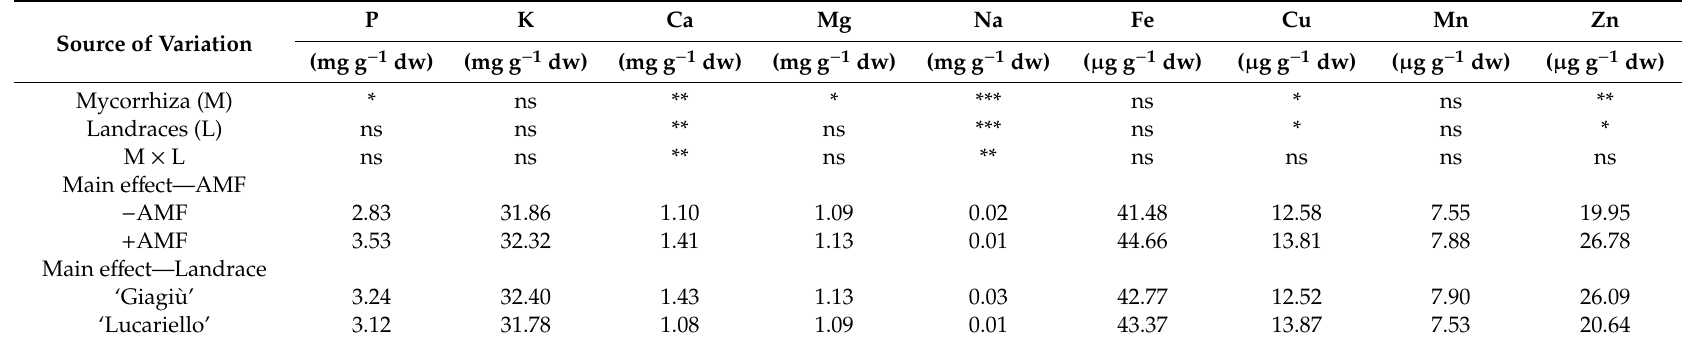
Table 2. Significance of the main e ff ects and the interactions on the macro (phosphorus, potassium, calcium and magnesium) and micro (sodium, iron, copper, manganese and zinc) mineral content. Values represent means of three